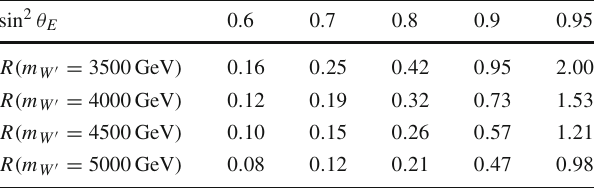
Table 3 The numerical results for the relative corrections of W (cid:2) pre- dicted by the NU model to the decay B − → γ e − ¯ ν e in the down-quark mixing scenario, in unit of 10 − 2